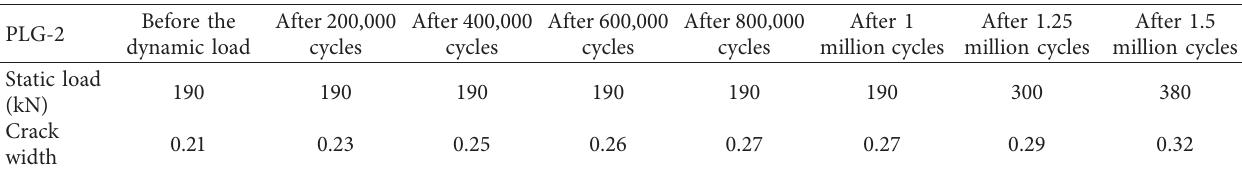
Figure 17: The largest crack in the concrete slab of PLG-1. (a) 380kN. (b) After 250,000 cycles. (c) After 1 million cycles. Table 5: Cracks of concrete slab of PLG-2 (unit: